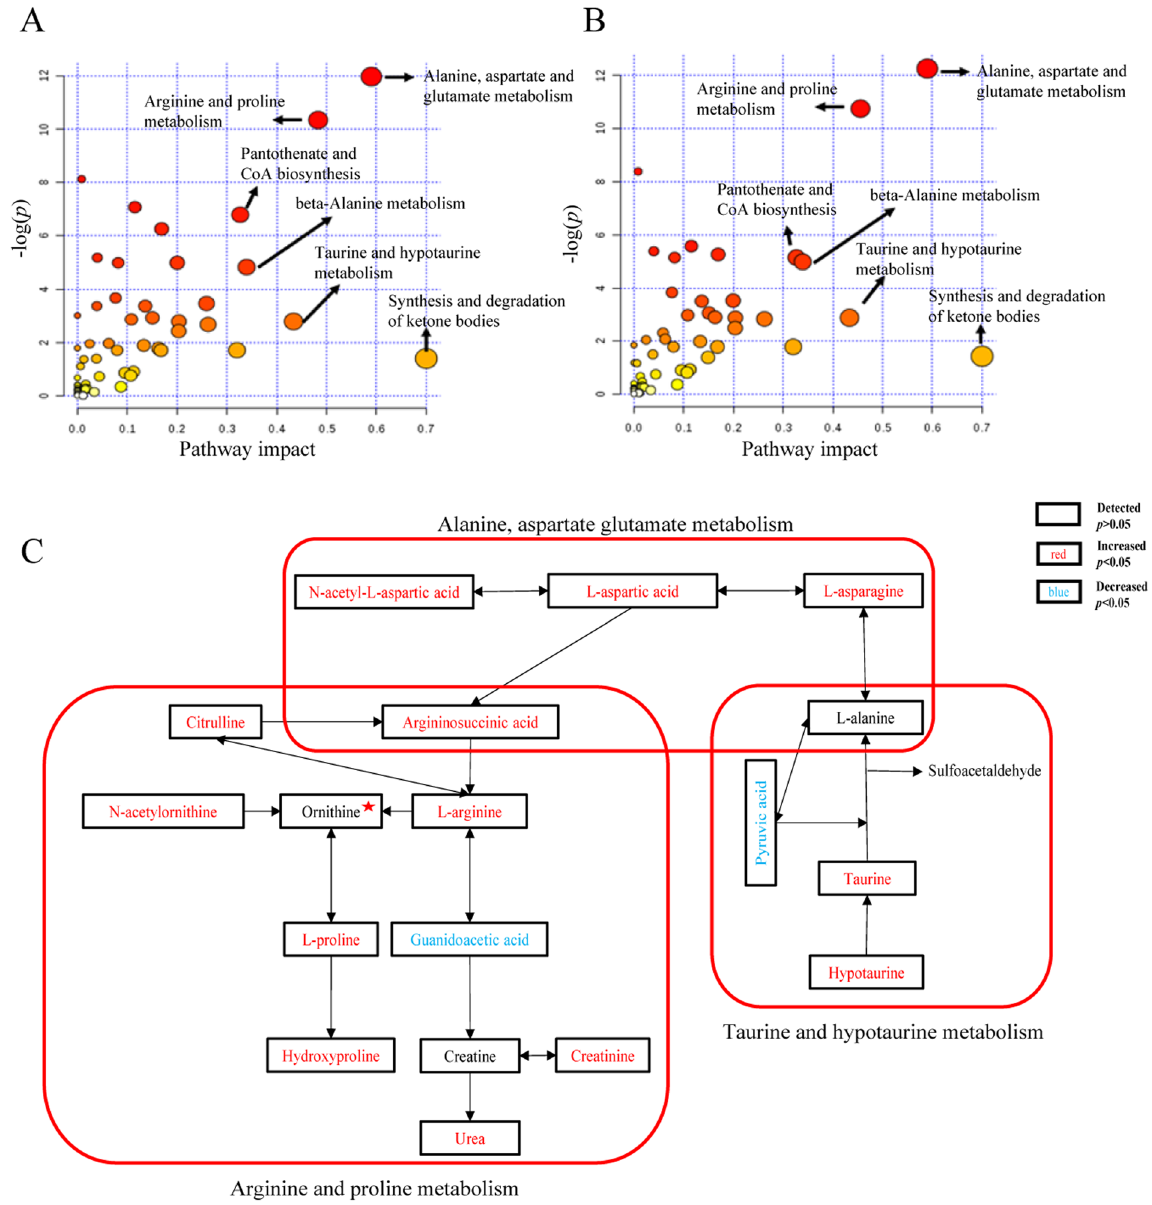
Figure 3. Metabolic comparison between patients and controls. ( A ) Changed pathways in uremia before treatments in pre-HD patients. ( B ) Changed pathways in uremia before treatments in pre-HFD patients. ( C ) Detailed changes of 18 metabolites in three important metabolic pathways when pre-dialysis patients are compared to controls. Metabolites marked with a red pentagram represent no differences between pre-HFD and the controls but are significantly reduced in pre-HD vs. the